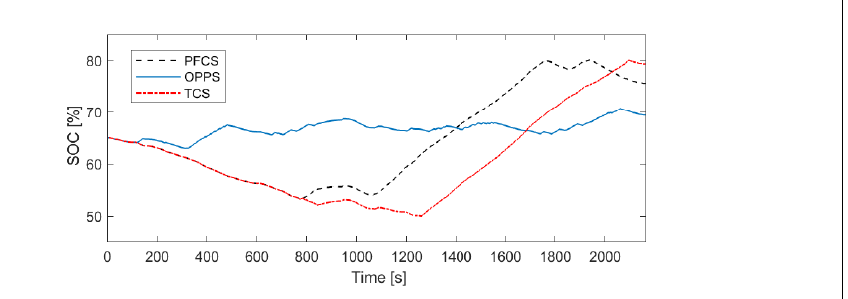
Figure 5 – Charge profiles for the TCS, the PFCS, and the OPSS Рис. 5 − Диаграмма изменения значений SOC относительно стратегий TCS, PFCS и